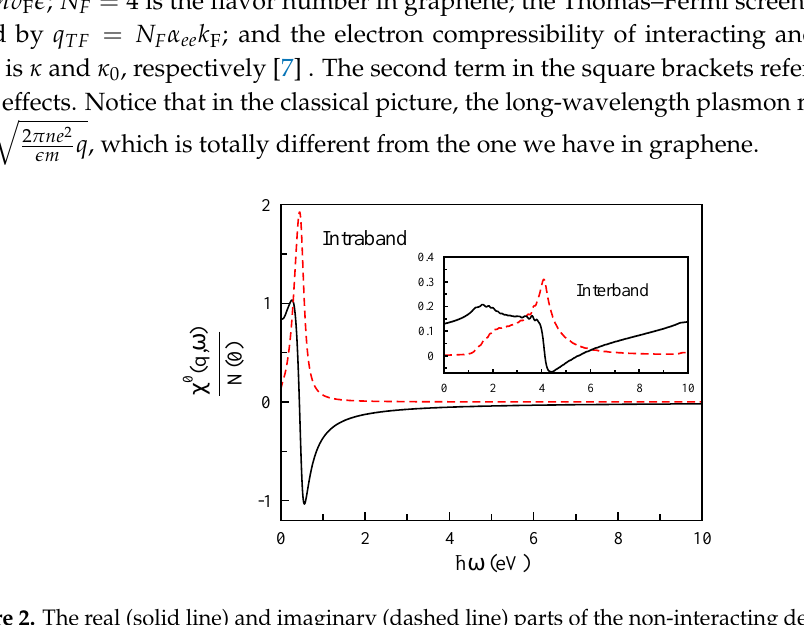
Figure 2. The real (solid line) and imaginary (dashed line) parts of the non-interacting density response function of monolayer graphene in units of the Fermi-level density of states as a function of ¯ h ω for q = 0.076 Å − 1